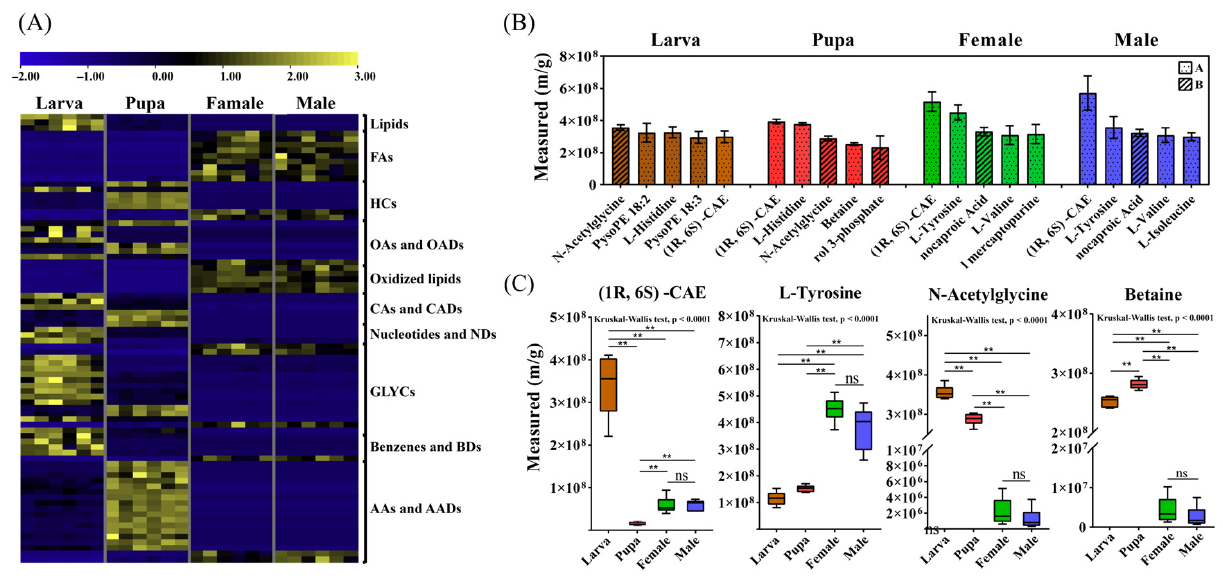
Figure 3. The overview of metabolomes of different developmental stages. ( A ) Heat map of 120 DAMs with significant difference in two transitions of successive stages (larva to pupa and pupa to adult). The level of metabolite increases from blue to yellow. ( B ) The top five small-molecule chemicals (heavyweights) with the highest content at each stage, respectively. The level of substance identification was indicated by letters. The ‘A’ and ‘B’ represent ion fragments of two and one metabolites detected, respectively. ( C ) Four metabolites that remains high content throughout ontogeny. Statistical significance is indicated as asterisks in figures as (ns) for p > 0.05, (*) for p < 0.05, (**) for p < 0.01, and (***) for p < 0.001. Different stages of K. inachus are represented by different colors (larvae: brown; pupae: red; male adults: blue; female adults: green).